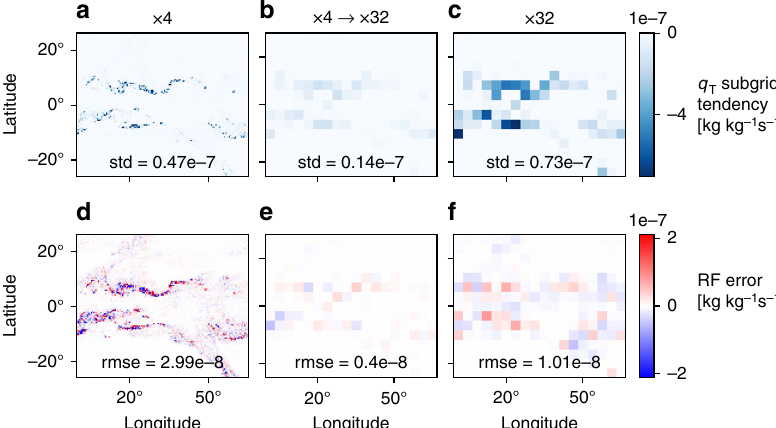
Fig. 4 Of fl ine comparison of random forest parameterizations at a common grid spacing. Snapshot of the subgrid tendency of q T at 5.7 km in kg kg − 1 s − 1 showing a – c the true tendency and d – f the error in the prediction from RF-tend. Results are shown for a , d subgrid tendencies calculated and predicted at x4, b , e coarse graining of the subgrid tendencies calculated and predicted at x4 to x32 grid spacing (x4 → x32), and c , f subgrid tendencies calculated and predicted at x32. Inset text gives for the snapshot shown a – c the standard deviation of the true tendencies and d – f the root mean square procedure as x4 → x32 (Fig. 4b and methods). The RMSE for substantially smaller than for x32 (compare Fig. 4e, f). Therefore, x4 → x32 is substantially smaller than for x4 because the x4-RF has smaller of fl ine errors compared to x32-RF when these stochastic component averages out with coarse-graining (com- parametrizations are compared in an apples-to-apples compar- pare Fig. 4a, b). Importantly the RMSE for x4 → x32 is also ison at the same length scale, and this is consistent with the better